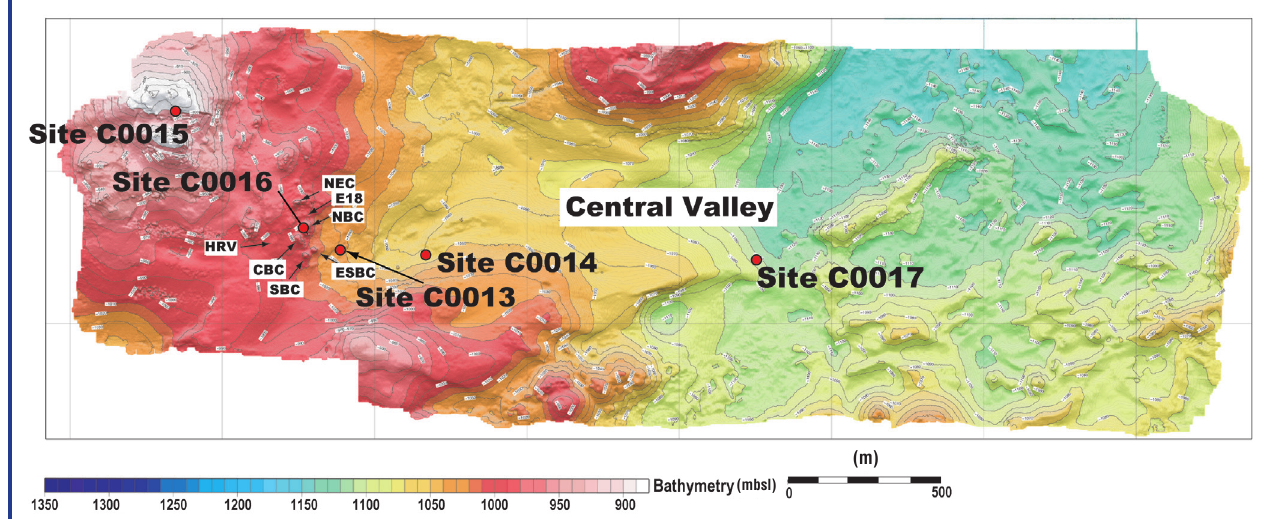
Figure 3. Detailed bathymetry of the Iheya North hydrothermal field and the central valley at Iheya North Knoll, with the location of Sites C0013– C0017 drilled during Expedition 331. HRV=High Radioactive Vent mound, CBC=Central Big Chimney mound, SBC=South Big Chimney mound, NEC=North Edge Chimney mound, E18=event Marker 18 mound, NBC = North Big Chimney mound, ESBC=“Ese” South Big Chimney mound. Modified from Takai et al.